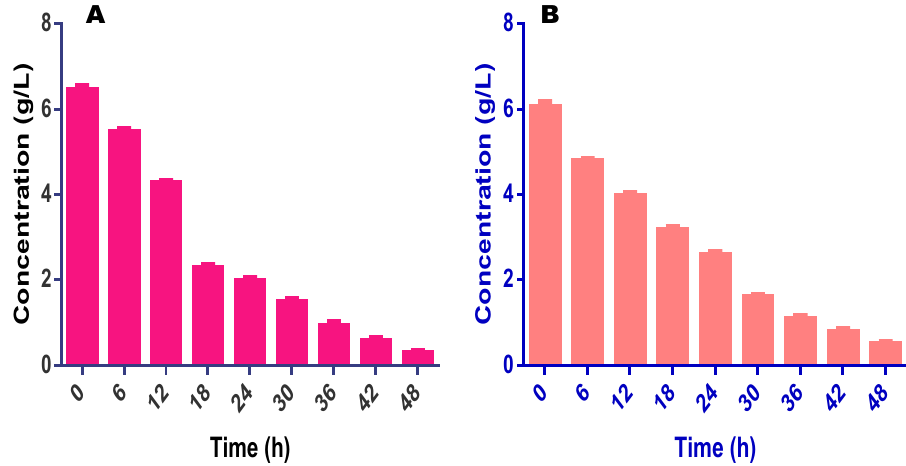
Figure 4. This figure shows the pattern of total organic carbon (TOC) conversion for ( A ) food wastes and ( B ) spent animal beddings during the experiments.